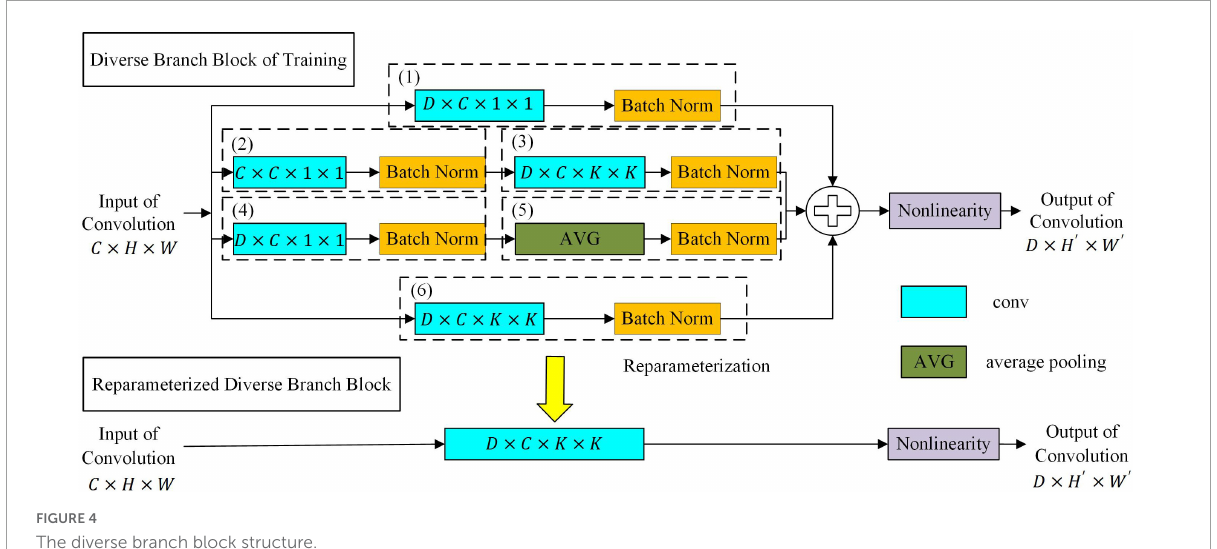
FIGURE4 The diverse branch block structure.